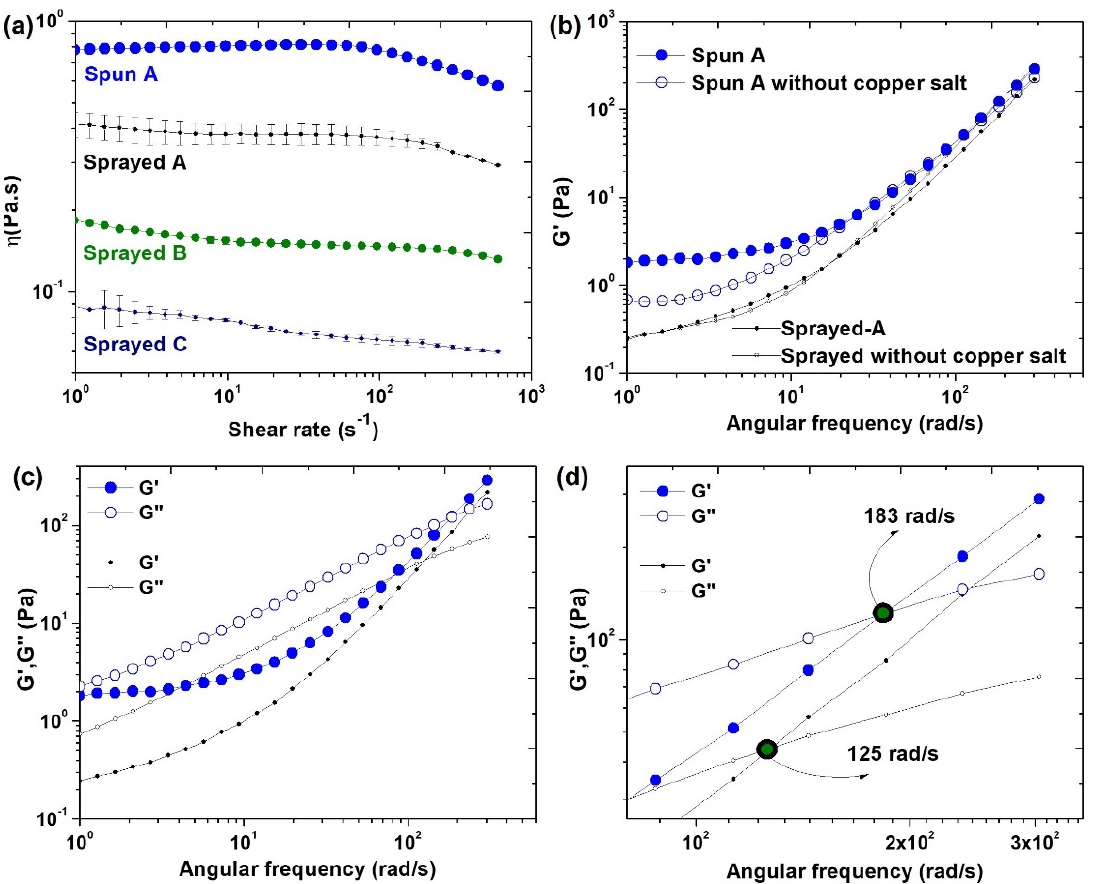
Figure 6. Rheological properties of the electrospinning and electrospraying solutions. ( a ) Steady-state viscosity curves of the spun A, sprayed A, sprayed B, and sprayed C solutions; ( b ) dependence of G’ on angular frequency; ( c ) dependence of G’ and G” as a function of the angular frequency; and ( d ) crossover G’ and G” for spun A and sprayed A. Note: sprayed B and sprayed C did not show cross ‐ over.